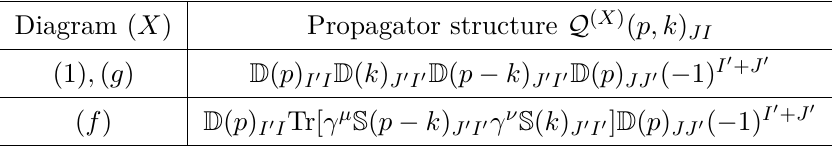
Table 1. Summary of propagator structures of diagrams with 4 propagators contributing to (cid:2) (cid:3) da g ++ . Summation over repeated I 0 , J 0 indices is implicit, even when there are three or more E ji,JI instances of such indices. Because fermionic propagators are intrinsically matrix-valued objects, we have made the choice to define the propagator structures with the gamma matrices included from the start. Fermionic propagators S IJ are defined in appendix B.